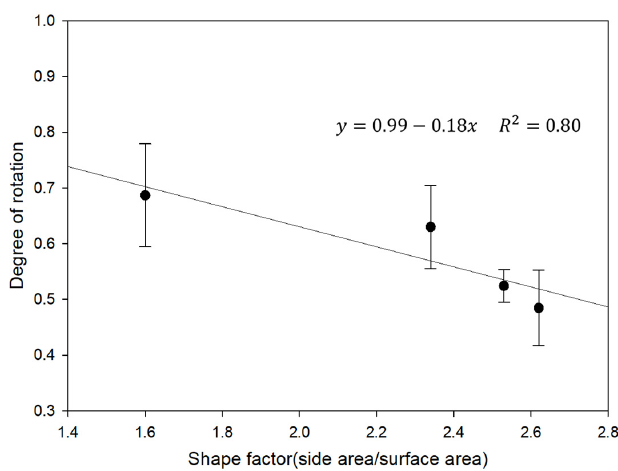
Figure 10. Relationship between rotation and shape factor (joint filling = 100%).